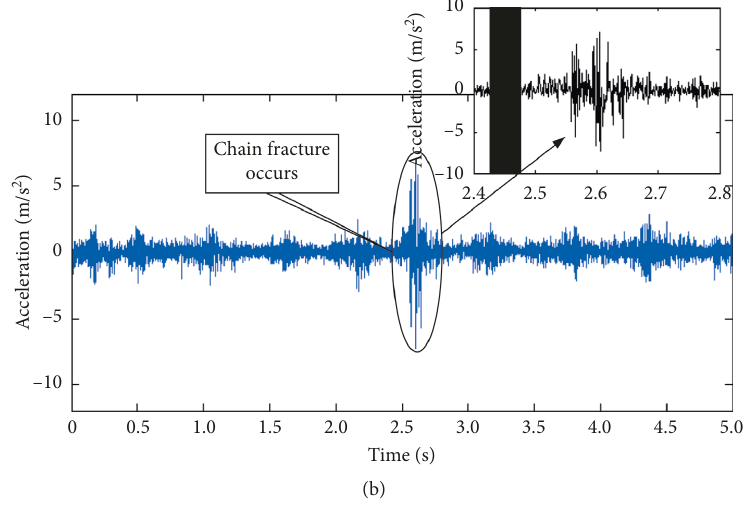
Figure 11: Vibration signals of the measuring point #1 for (a) chain jam and (b) chain